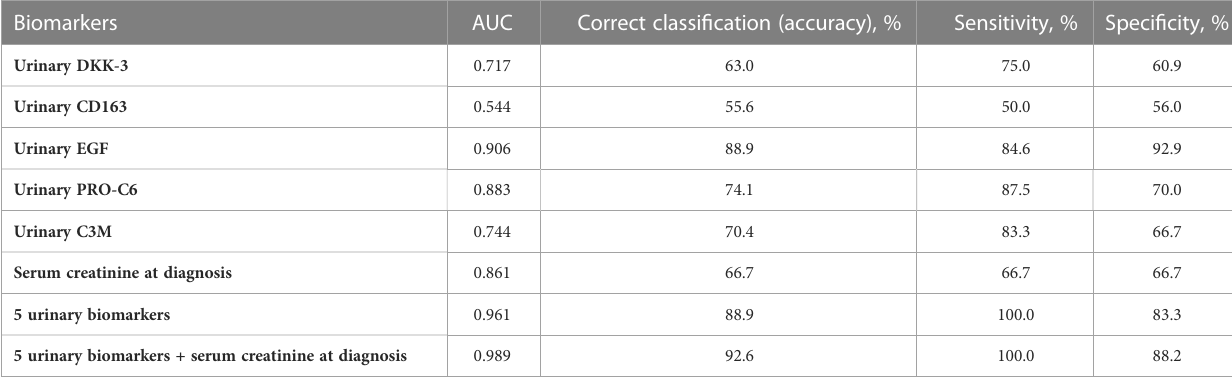
Serum creatinine at diagnosis